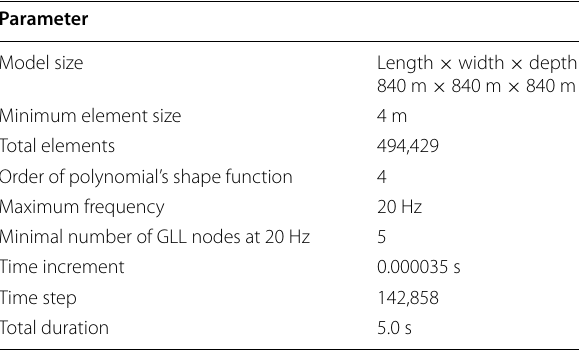
Table 3 Conditions for the 3-D SEM calculation